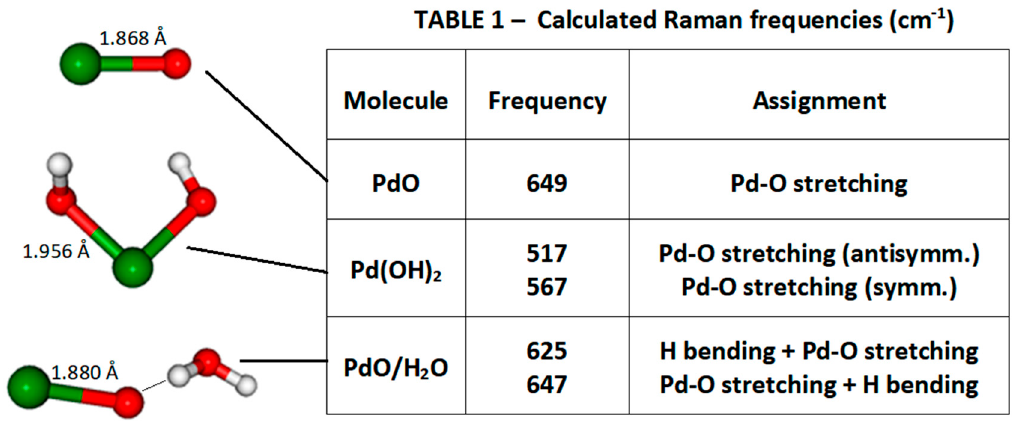
Figure 6. Calculated Raman frequencies for the possible species present in the colloidal nanoparticles, whose optimized structures are shown.